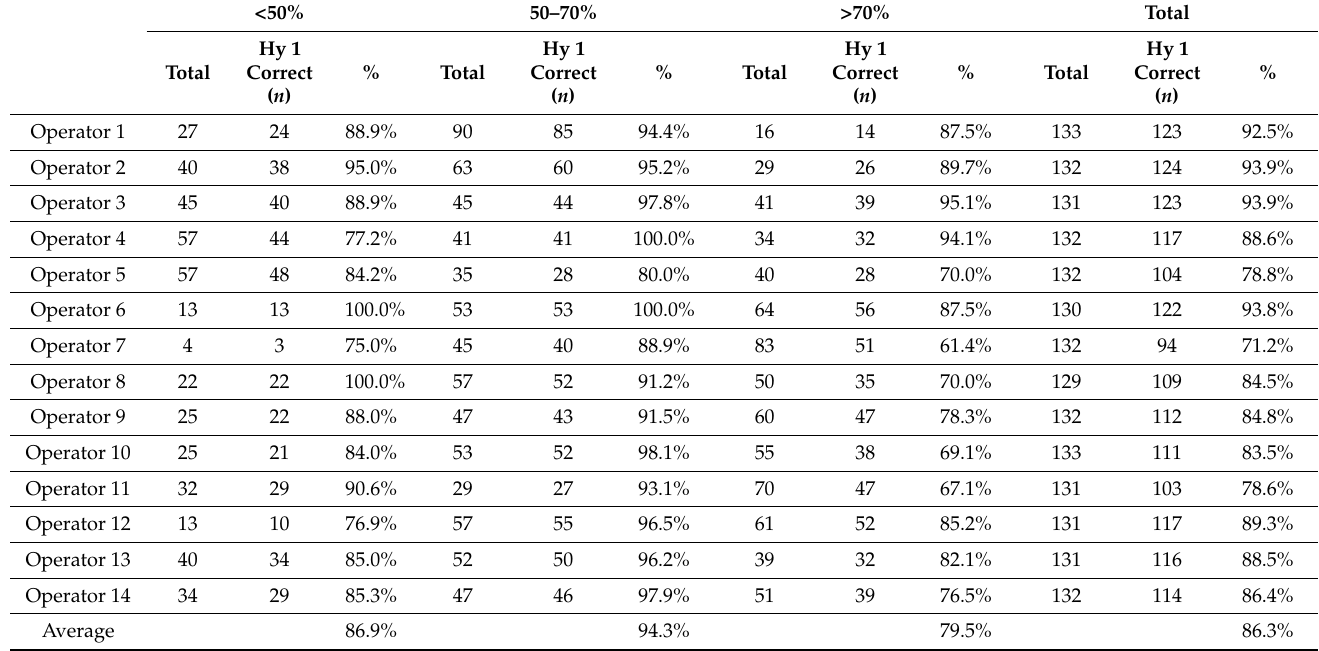
Table A3. Performance of the Hybrid 1 (Hy1) strategy based on three degrees of stenosis (as judged by each operator).